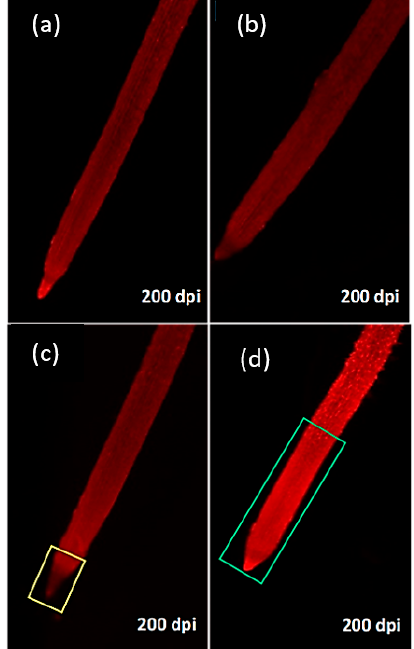
Figure 5. Rh123-stained root tips showing normal bright fluorescence in control treatment in the adapted genotype ( a ) and non-adapted genotype ( b ). Root tip meristem fluorescence decline at 10% PEG treatment ( c ) marked with yellow-colored quadrangle, and a hyperpolarization status at 10% PEG treatment in sensitive genotypes ( d ) marked with green-colored quadrangle.